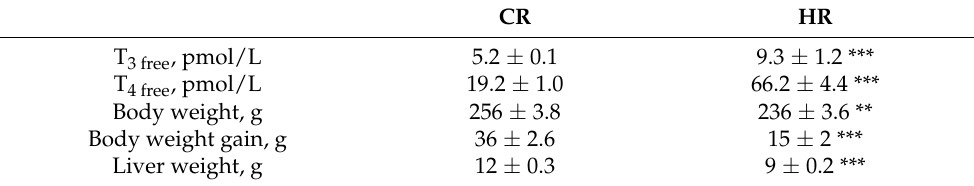
Table 1. T 3 (free) and T 4 (free) concentrations, body and liver weights in control and hyperthyroid rats. CR HR T 3 free ,